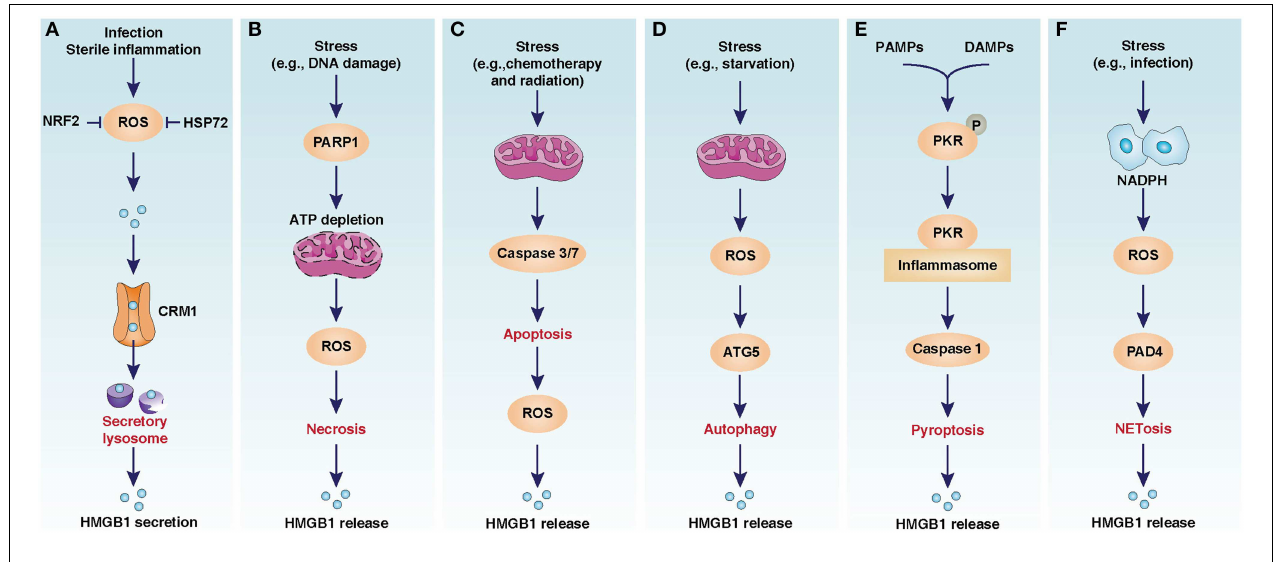
FIGURE 1 | Oxidative stress-mediated HMGB1 release in infection, inflammation, and cell death. (A) CRM1-mediated nuclear export of HMGB1 in activated immune cells. (B) PARP1-medaited HMGB1 release in necrosis. (C) Caspase3/7-medaited HMGB1 release in